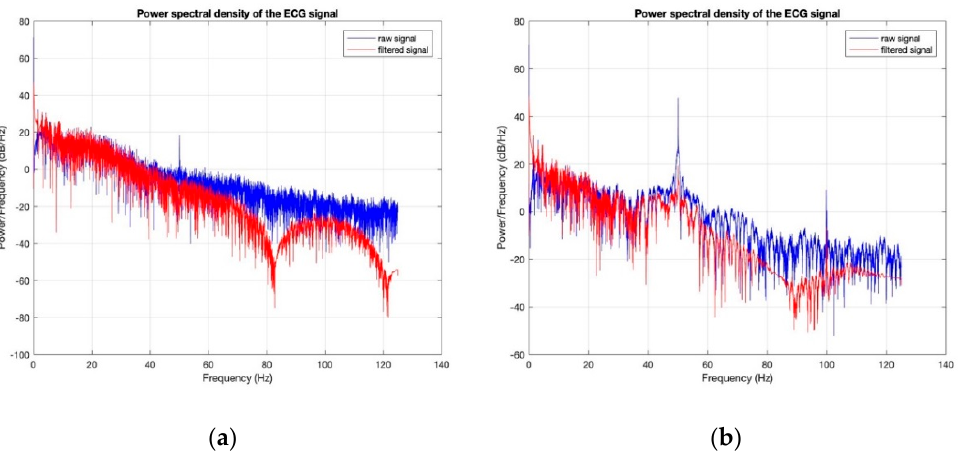
Figure 21. Power Spectral Density of ECG signal obtained by 100% cotton electrodes with 12.8 wt.%